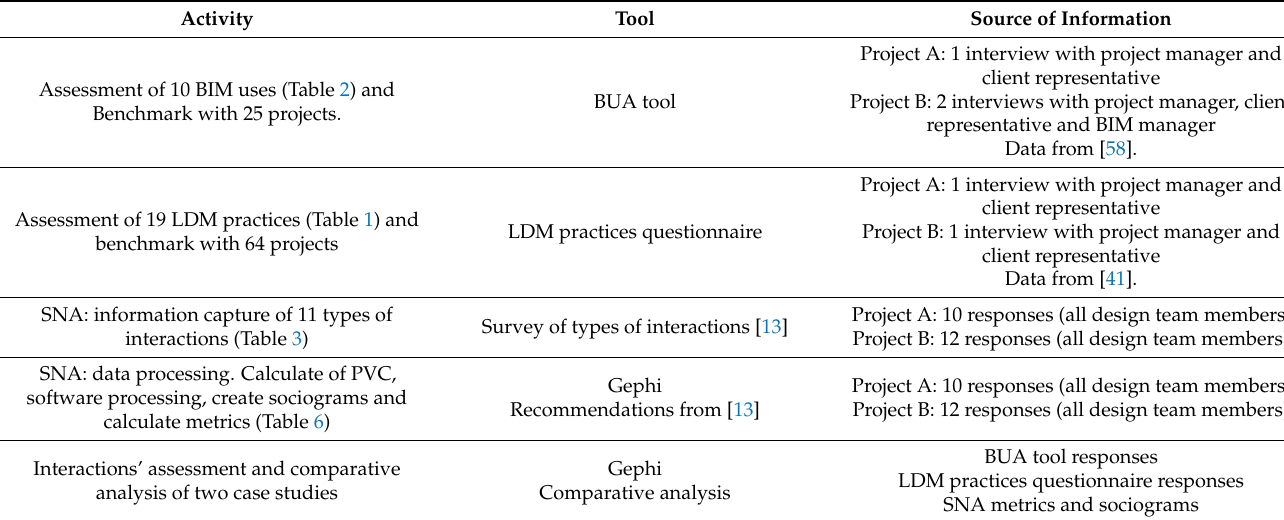
Table 7. Overall research